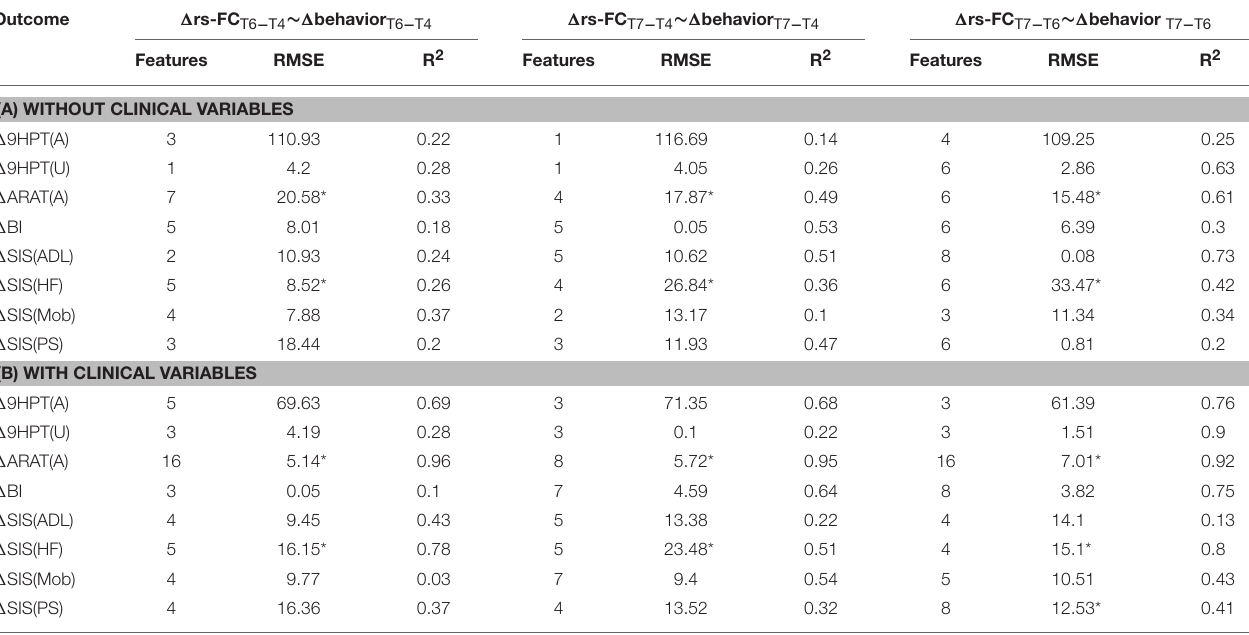
TABLE 6 | Linear-kernel SVR performances based on leave-one out cross-validation to correlate 1 rs-FC between two time-points with 1 behavioral measures between corresponding time-points are presented.